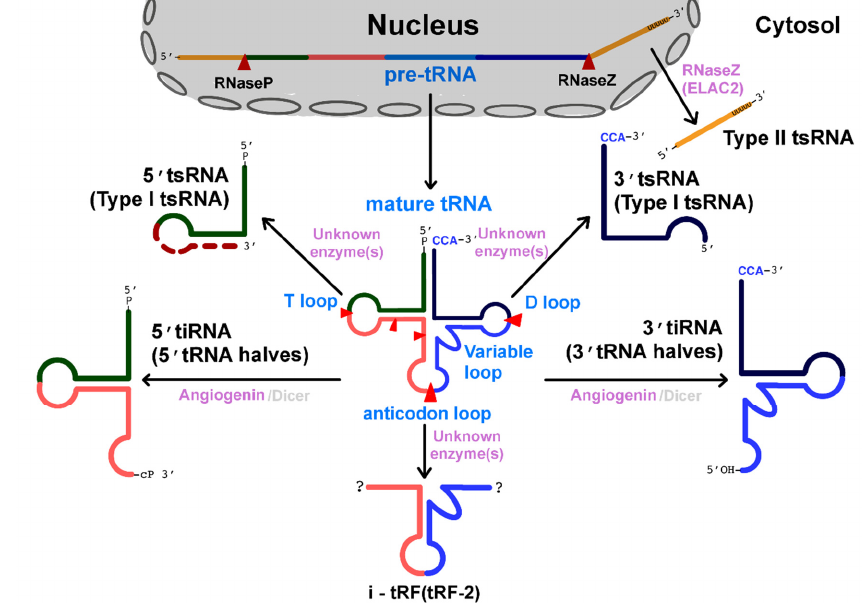
Figure 1. Classification and biogenesis of tRNA-derived small RNAs. More than 6 types of tsRNAs have been classified based on the site at which precursor tRNAs are cleaved. tsRNAs are formed by the processing of their precursors (i.e., mature tRNAs or pre-tRNAs). Cleavage sites are indicated by red arrowheads. Variations in length observed in 5 (cid:48) tsRNAs (Type I tsRNAs) are indicated by a red dotted line. tRNA halves are primarily processed by angiogenin and Dicer proteins (the name of the minor processing enzyme is shown in gray). The major processing enzymes for other tsRNAs generated from mature tRNAs have not been